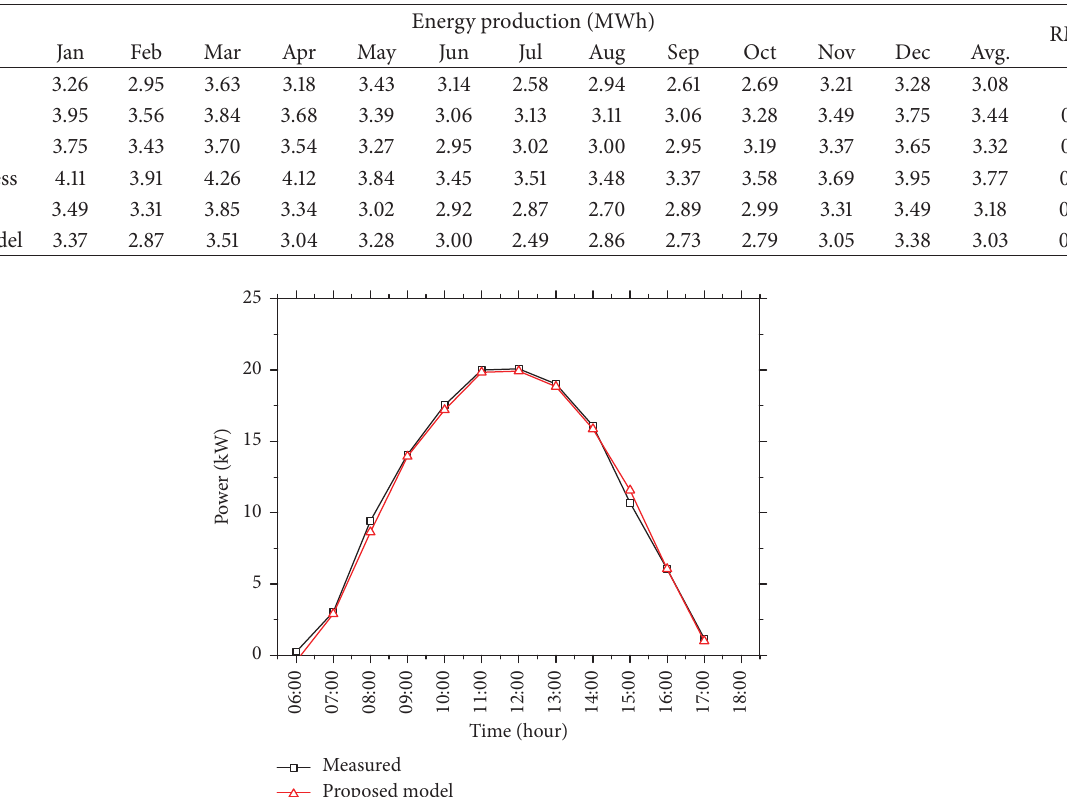
Table 8: Comparisons of measured data with other simulators and our developed simulated model.